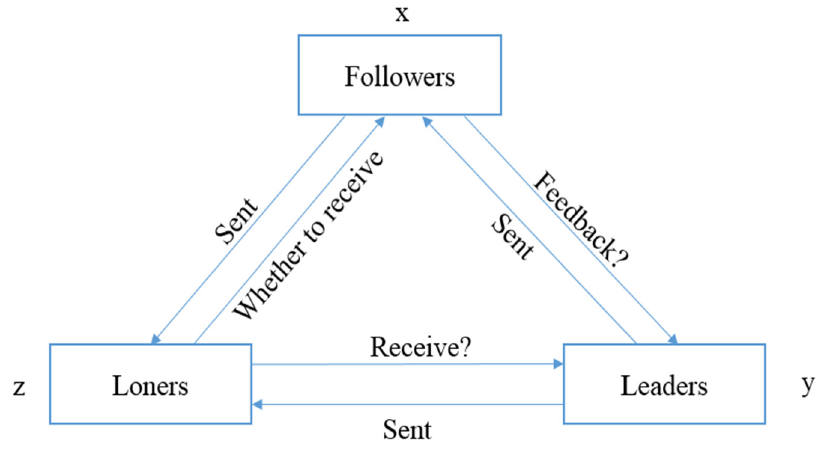
Figure 1. Multi-agent system model.